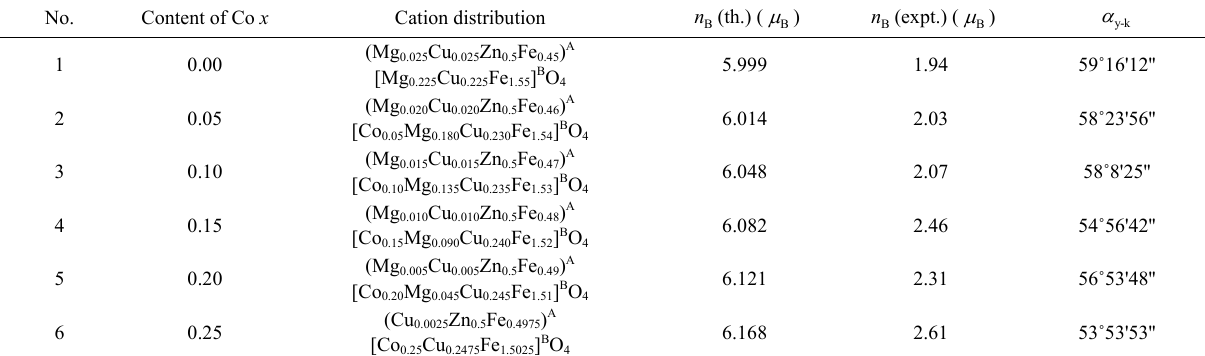
Table 4 Probable cation distribution and the magnetic moments of all the ferrites No. Content of Co x Cation